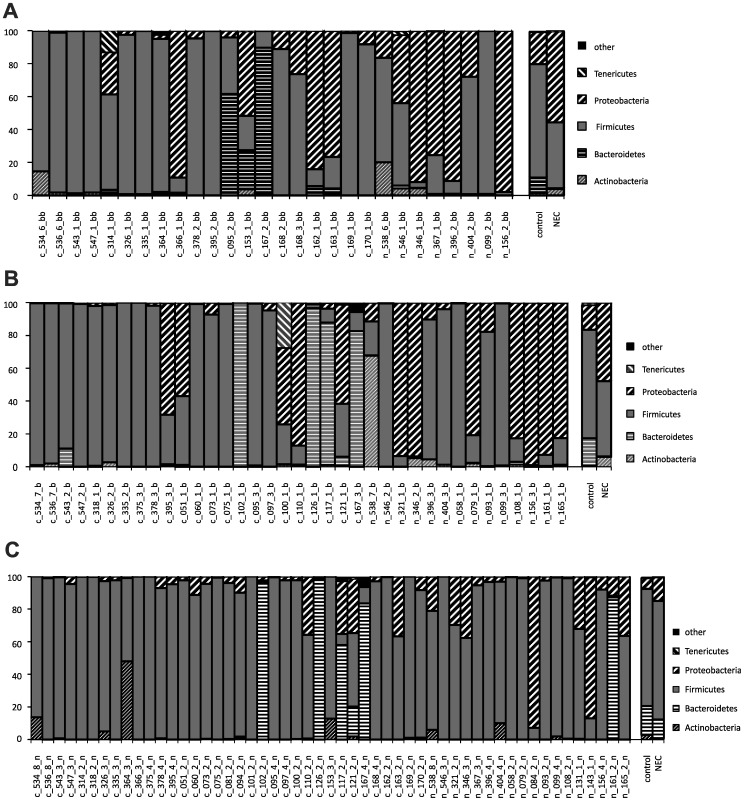
Changes in proportions of bacterial phyla.Proportions of the major bacterial phyla at A) two weeks before, B) one week before, and C) during week of NEC diagnosis for individual samples from controls (c_###) and NEC cases (n_###) and means for samples combined by NEC status (control, NEC).